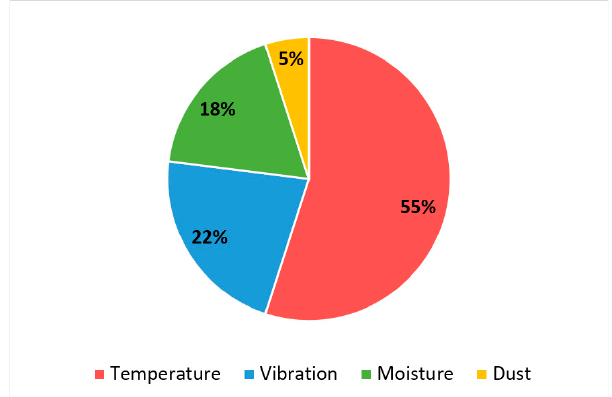
Figure 1. Distribution of the most frequent causes of electronic failures [22].